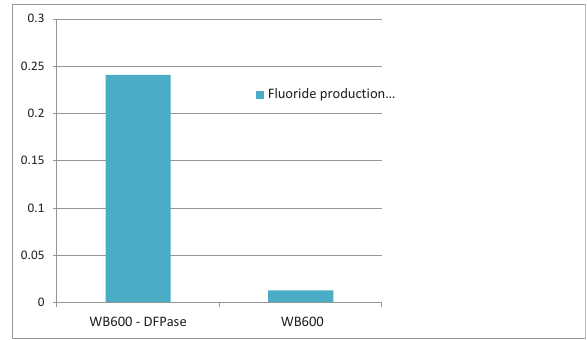
00.050.10.150.2 Figure 5 . Released fluoride detected by ion selective electrode in B. Subtilis WB600 and B. Figure 5 . Released fluoride detected by ion selective electrode in B. subtilis WB600/ dfpase supernatant cultures after 72 hours incubation. Subtilis WB600 and B. subtilis WB600/ dfpase supernatant cultures after 72 hours